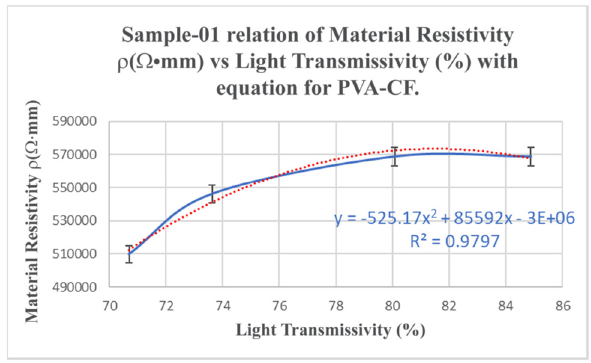
Figure 26: Sample - 01 ( CF:PVA = 0.1:30 ) material resistivity ρ ( Ω mm ) versus light transmittance ( % ) with equation for PVA - CF. The dotted lines represent the polynomial fi tted curve and the linear fi tted.